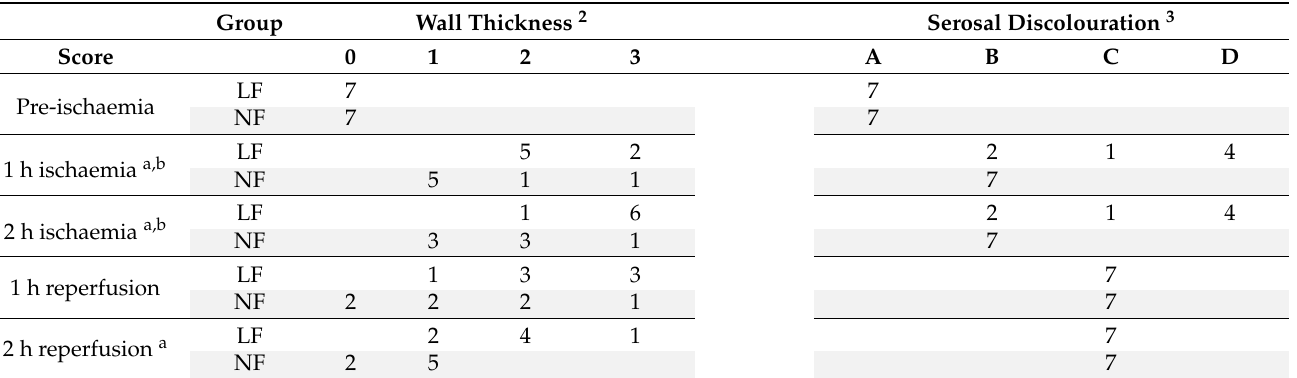
Table 4. Frequency distribution of intestinal wall thickness and discolouration of jejunum subjected to LF and NF